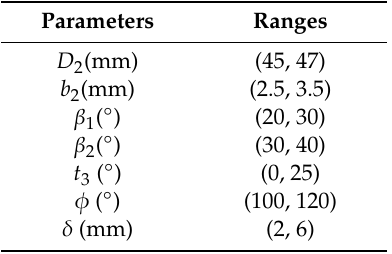
Table 9. Ranges of optimization variables.